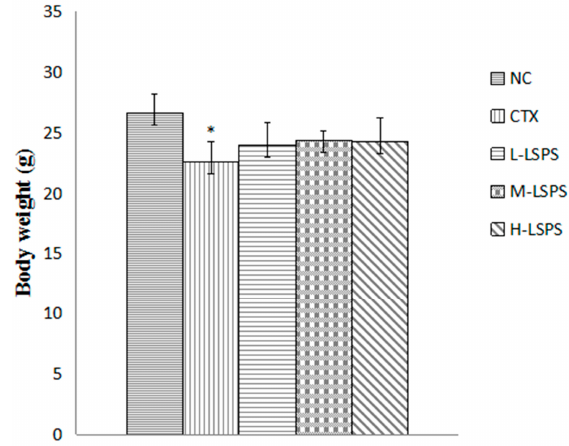
Figure 4. Effects of LSPS on body weight in H22 tumor-bearing mice. The results are expressed as means ± SD of 10 separate experiments. Compared with negative control (NC), * p < 0.05. CTX, cyclophosphamide (30 mg/kg) treated group; L-LSPS, lotus seed polysaccharide (50 mg/kg) treated group; M-LSPS, lotus seed polysaccharide (100 mg/kg) treated group; H-LSPS, lotus seed polysaccharide (200 mg/kg) treated group.